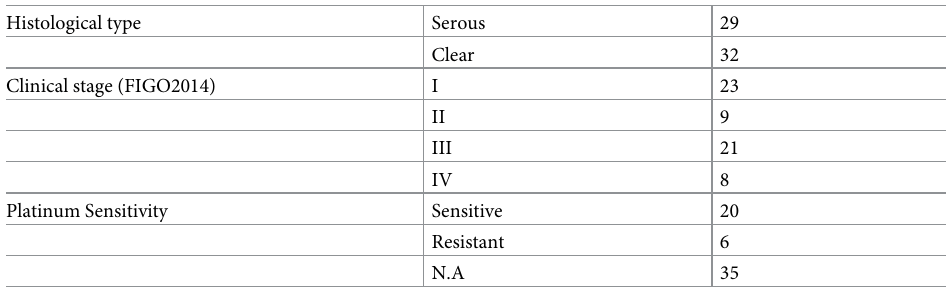
Table 1. Characteristics of ovarian cancer